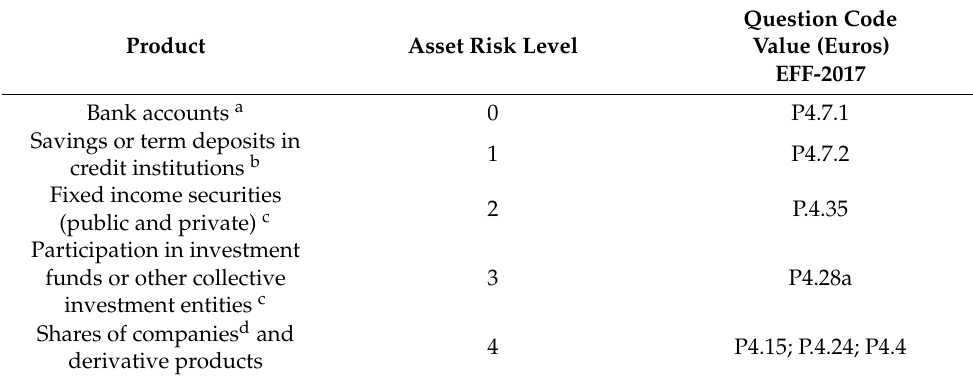
Table A1. Portfolio risk average.